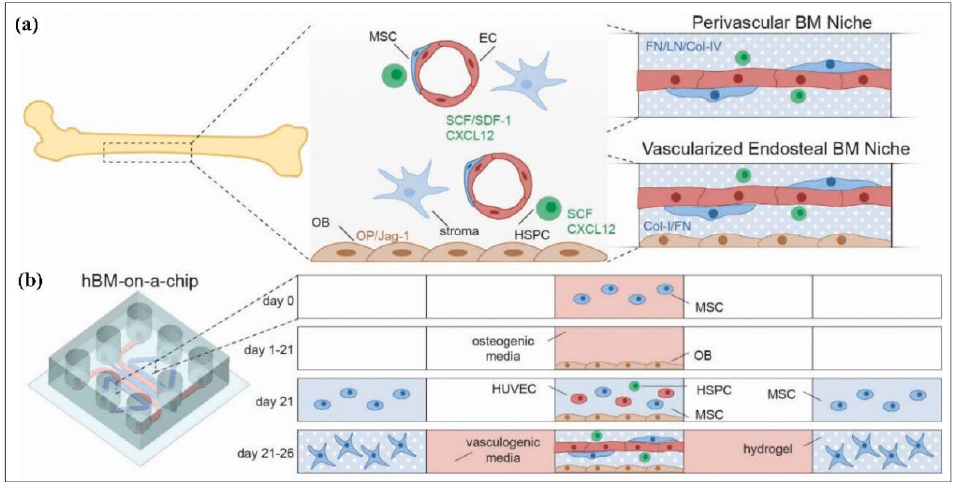
Figure 13. Schematic of human bone marrow-on-a-chip (hBM-on-a-chip) presented by Nelson et al. to investigate hematopoietic stem and progenitor cell behaviour and reaction to pathological stimulus. ( a ) The developed chip can mimic endosteal BM niche and central perivascular BM niche, which are present in long bones. OB = osteoblasts and mineralized bone-like tissue layer; MSC = mesenchymal or marrow stromal cells, including pericytes; stromal cells = other cells of the BM stroma including CXCL12-abundant reticular cells (CAR), matured hematopoietic cells, and adipose cells; HSPC = hematopoietic stem and progenitor cells; FN = fibronectin; LN = laminin, col I and IV = collagen I and collagen IV; OP = osteopontin; Jag-1 = Jagged 1. ( b ) Soft lithography was utilized to fabricate a 5-channel PDMS microfluidic platform. An endosteal layer was formed in the central channel with differentiation of MSCs for 21 days. After this, HSPCs, HUVECs, and MSCs were loaded and seeded on top of the endosteal layer for vasculogenesis. Reprinted with permission from ref. [363], Copyright 2021, Elsevier.